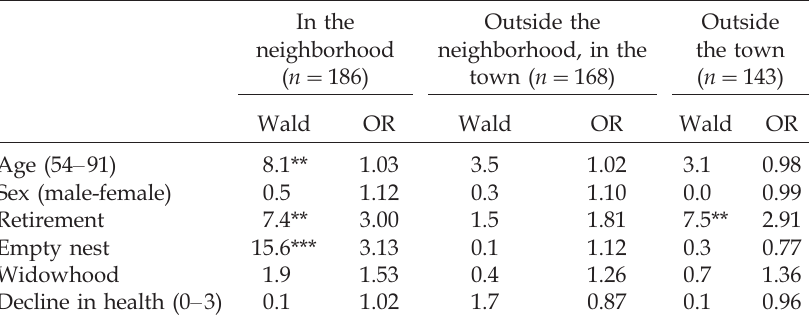
Table 3. Multinomial logistic regression analysis of distances of mo v es on life e v ents in other life domains ( n (cid:2)